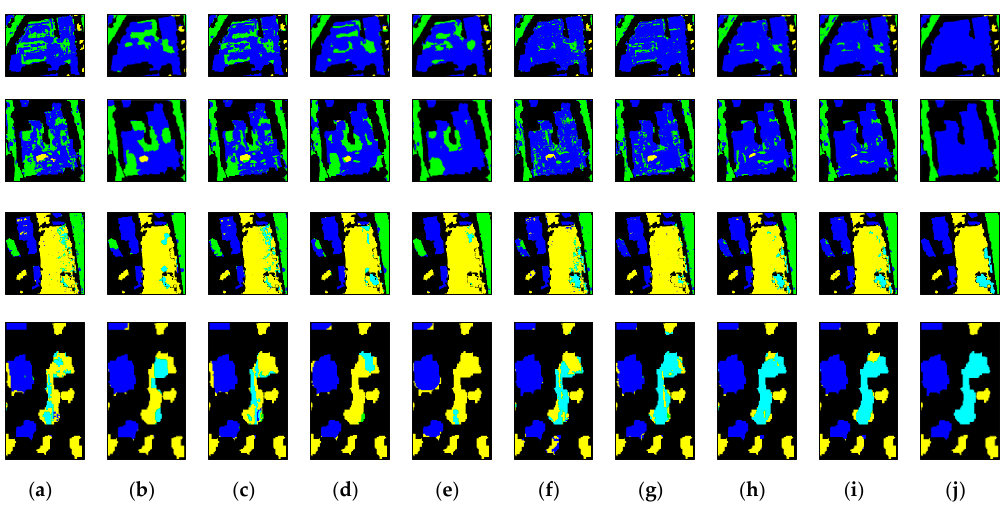
Figure 16. Comparison of local classification results obtained by: ( a ) original bands; ( b ) SLIC Raw (when S = 15); ( c ) PGF (with r = 2); ( d ) SGF (with r = 7); ( e ) GF Prob (with r = 14); ( f ) MPGF (with r = [1,30]); ( g ) EMPs (with r = [1,30]); ( h ) the proposed MSGF (with r = [1,30]); ( i ) the proposed FS-MSGF (with r = [1,30] and F = 40); ( j ) the reference map, where the four rows correspond to the four sub-regions highlighted in Figure 14 (Zh1). Remote Sens. 2020 , 1 , x FOR PEER REVIEW 17 of 19